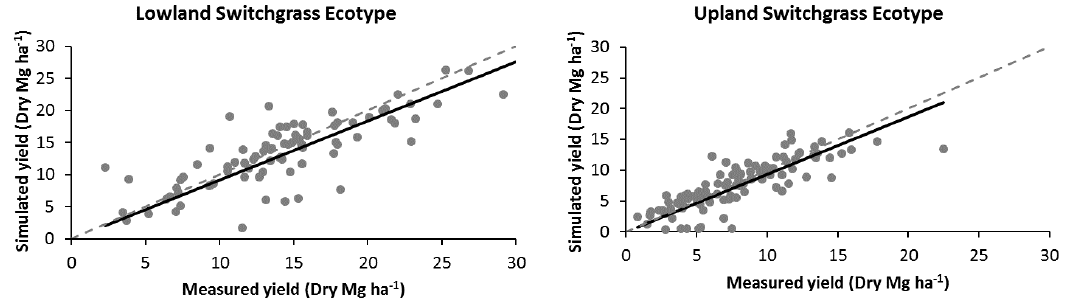
Figure 4. Results of model validation: relation between measured and ALMANAC simulated yields for lowland and upland switchgrass cultivars. The measured yields were averaged across cultivars within each ecotype from each study location. The solid line is the fitted regression line and the dash line is the 1:1 line.